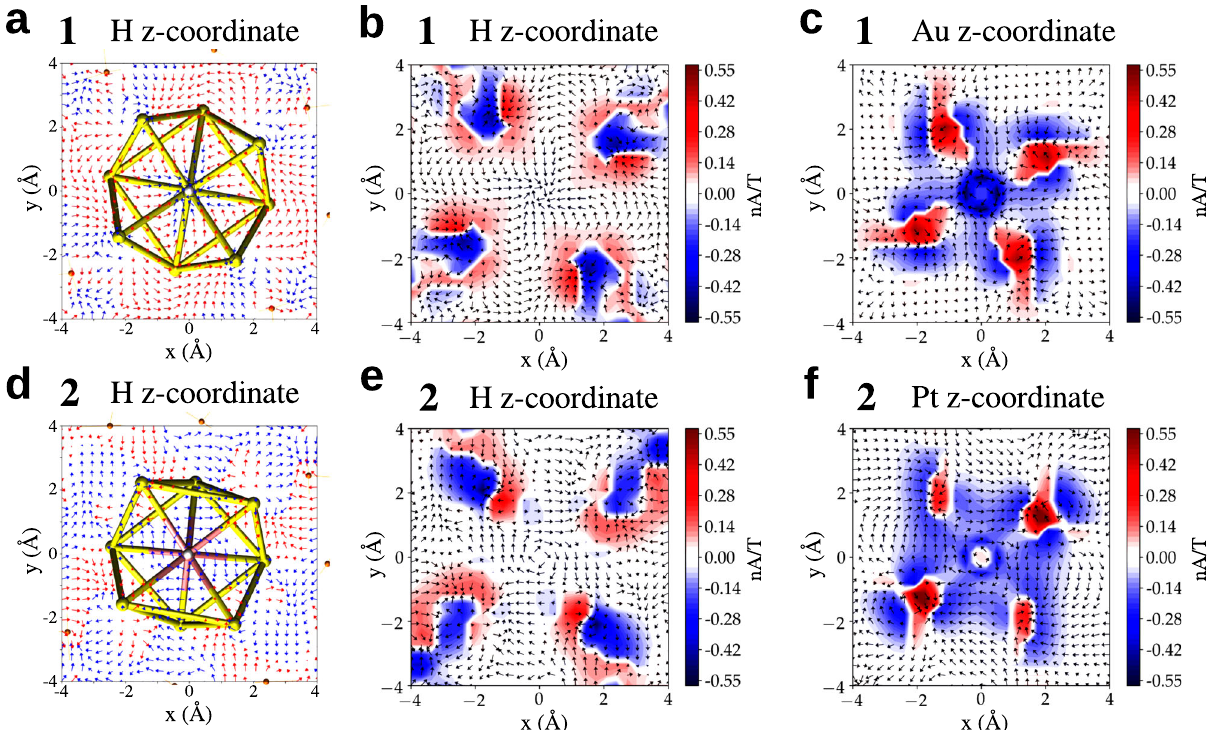
Fig. 2 Magnetically induced currents. Paratropic (red) and diatropic (blue) vectorial fi eld of the magnetically induced current density J(r) for ( a – c ) [HAu 9 (PPh 3 ) 8 ] 2 + (cluster 1) and ( d – f ) [HPtAu 8 (PPh 3 ) 8 ] + (cluster 2). Vectors projected on an x – y plane located at the z – coordinate of the core-hydrogen and the central atom (Au/Pt) and signed modulus of J(r) are shown. The external magnetic fi eld B is oriented perpendicular to the x – y plane and pointing towards the